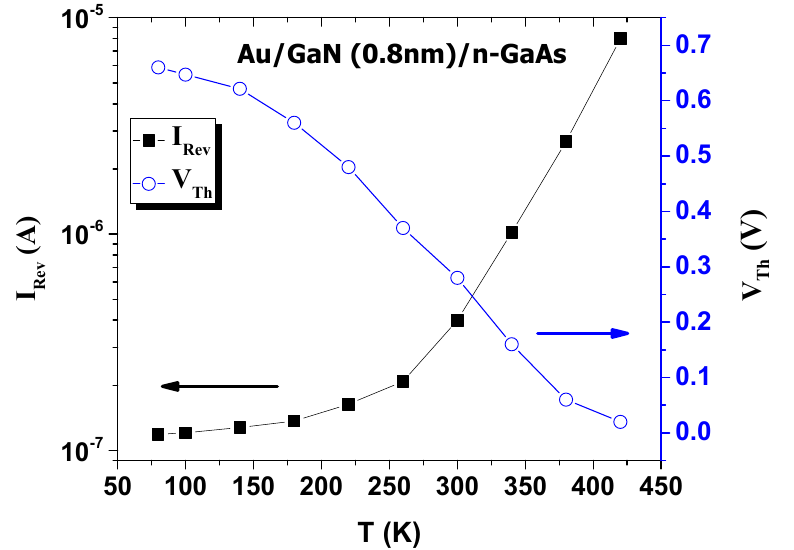
Figure 2. I − V measurements of Au/0.8 nm–GaN/n–GaAs structure, ( a ) semi-logarithmic scale and ( b ) linear scale.